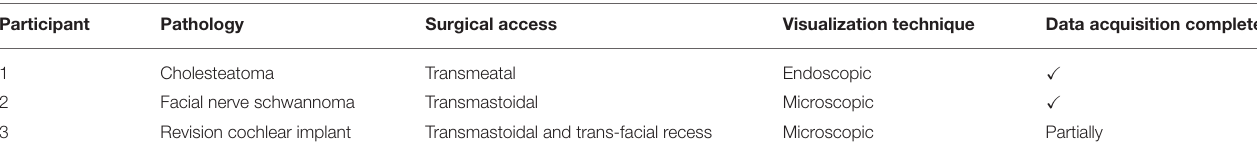
TABLE 1 | Study participants and their respective indications for surgery, access routes, visualization techniques, and whether study-related data acquisition was completed.